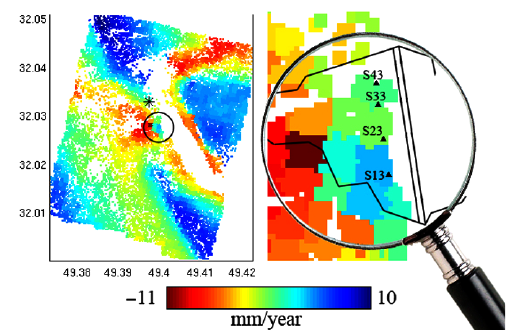
Fig. 6. Location of geodetic stations on velocity map